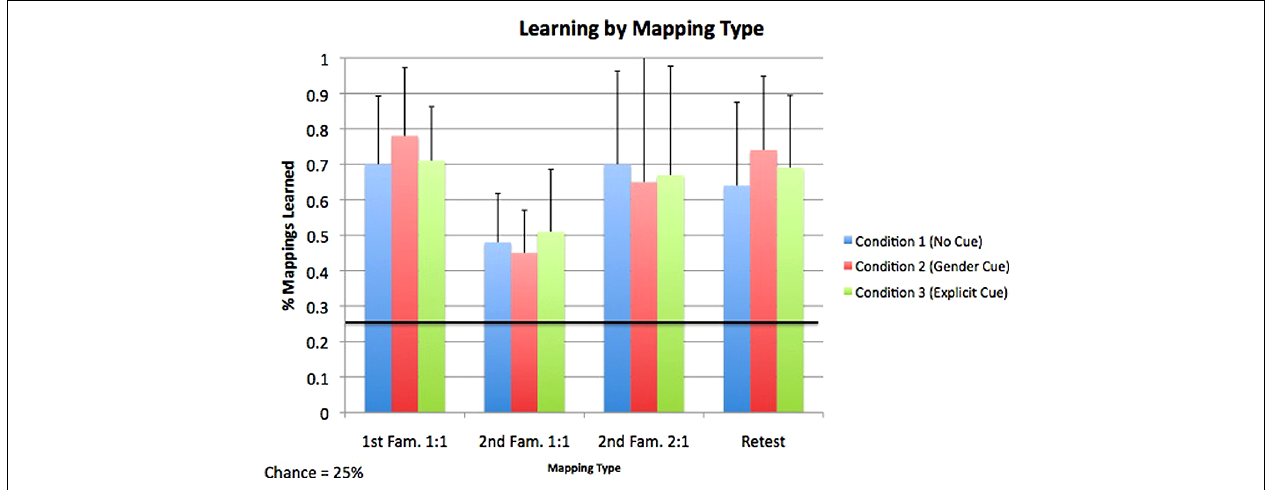
FIGURE 2 |Accuracy for each mapping type across each of the three experimental conditions. For all mapping types and in all conditions, accuracy was above the level of chance, indicating successful acquisition of both 1:1 and 2:1 mappings. Error bars represent one SE.